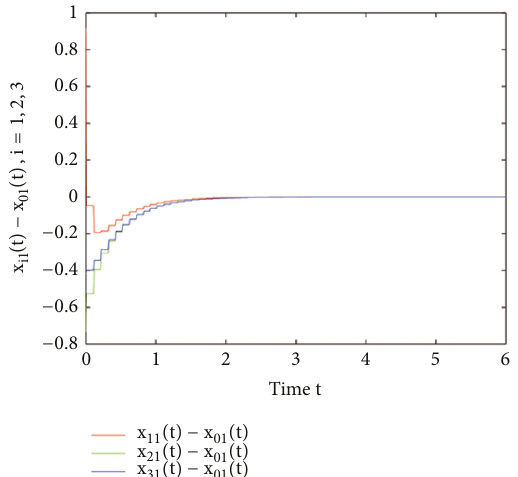
Figure 5:The 3 -dimensional error valueof agent 𝑥 𝑖 and leader agent 𝑥 0